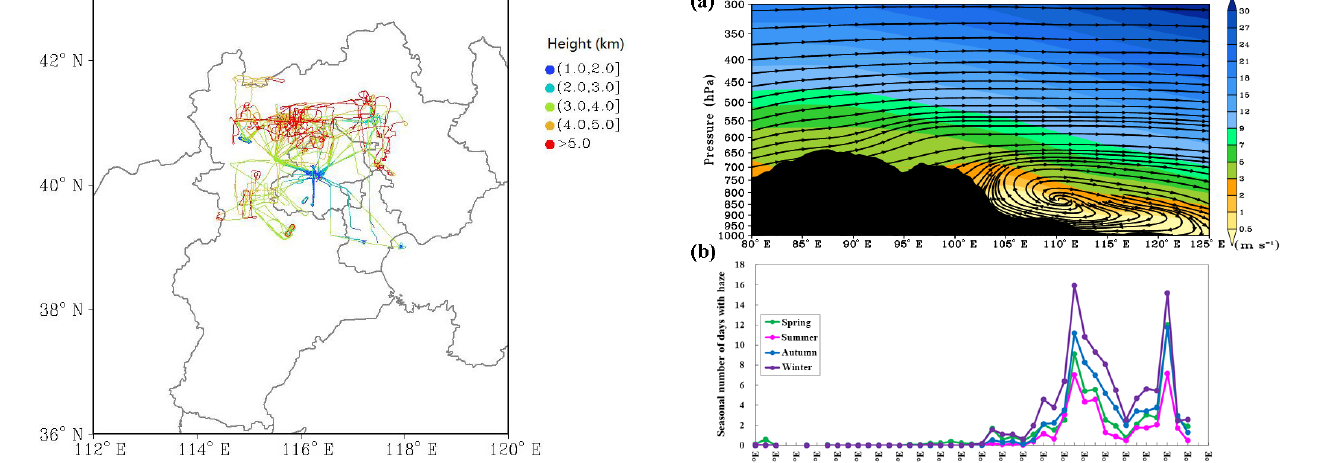
Figure 1. Area and tracks of 40 aircraft flights carried out in Bei- jing and its surrounding regions during aerosol–cloud experiments from 2008 to 2010 by the Beijing Weather Modification Office, China.